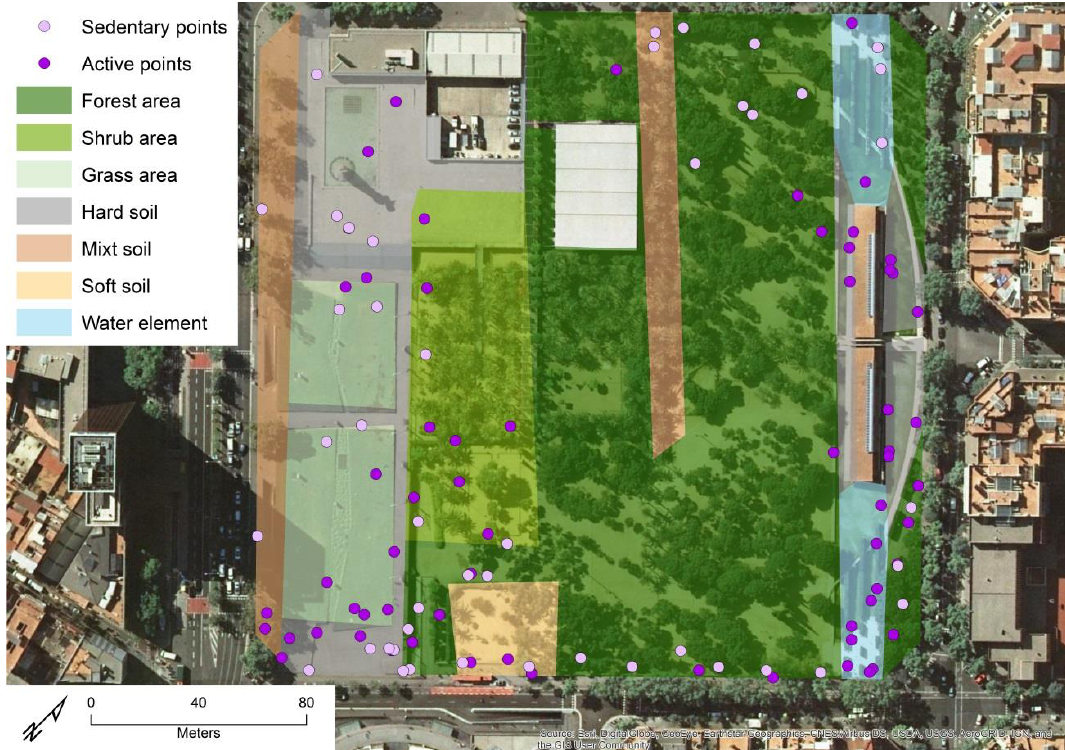
Figure 3. Example of GPS points of one participant in one of the selected UGS. Source: Own production based on ArcGIS © Online base map [51].